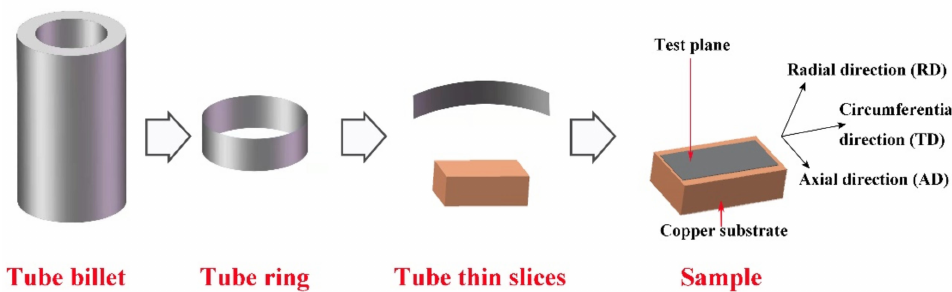
Figure 1. Schematic diagram of specimen